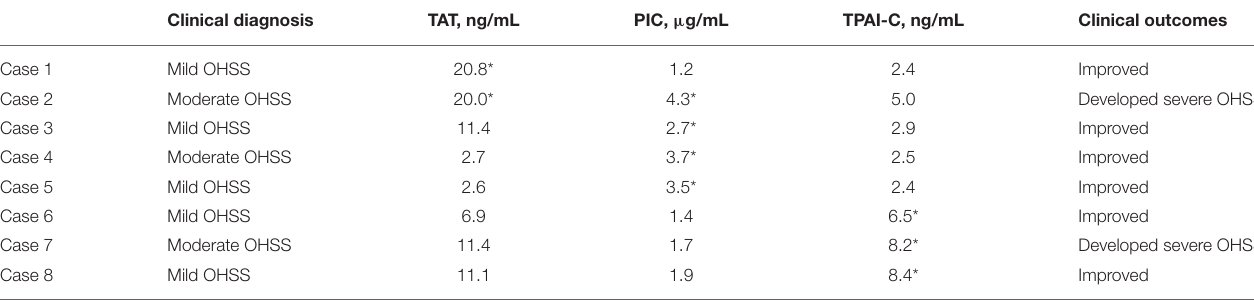
TABLE 3 | The outcomes of patients with mild–moderate ovarian hyperstimulation syndrome with positive biomarkers. Clinical